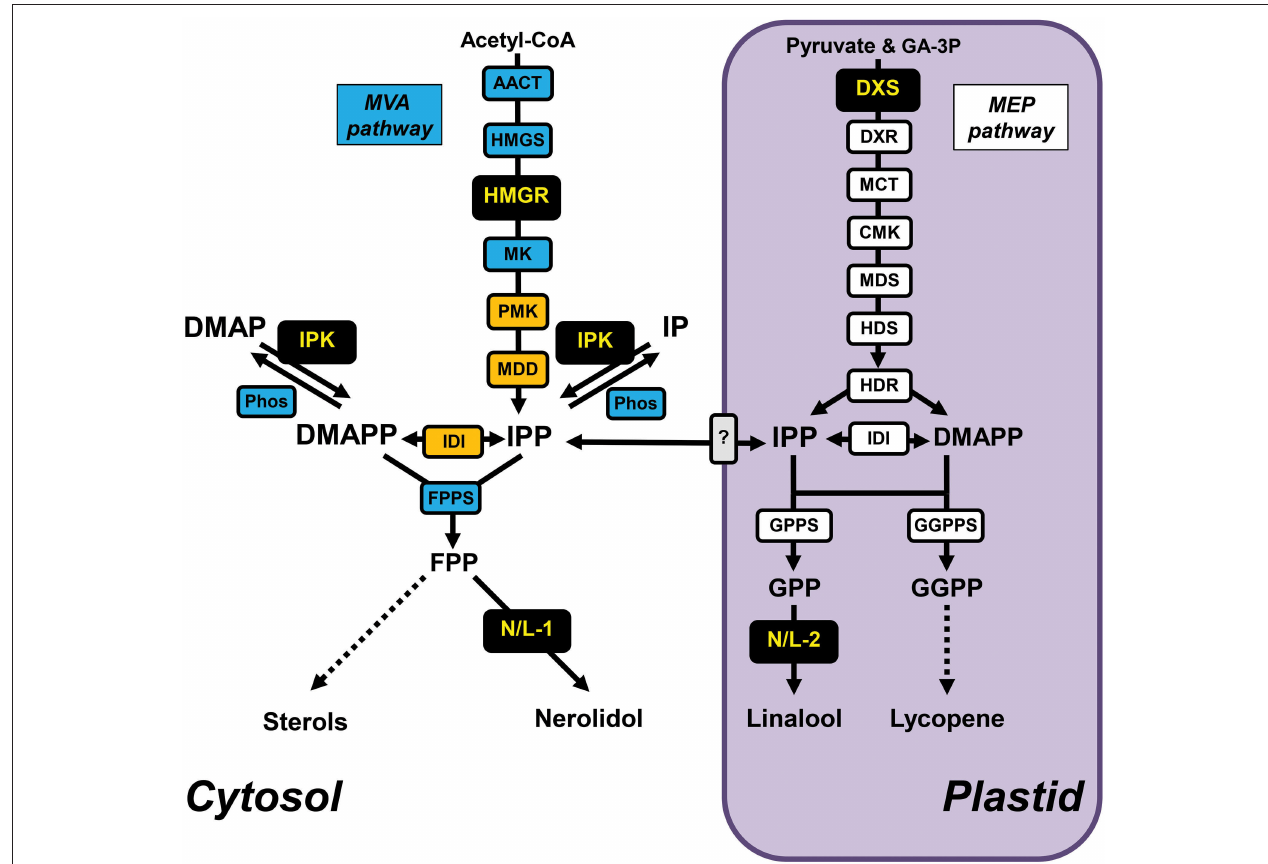
FIGURE 1 | Terpenoid metabolic network in tomato fruits and position of engineered enzymes. Cytosolic and plastidic (highlighted in purple) terpenoid metabolic pathways involved in the biosynthesis of sterols and lycopene in tomato fruits with individual enzymes depicted as boxes. The cytosolic MVA pathway enzymes, prenyl transferase, and Nudix hydrolase are highlighted in blue, peroxisomal MVA pathway enzymes are highlighted in orange, the plastidic MEP pathway enzymes and prenyl transferases are highlighted in white. The unknown transporter(s) involved in IPP exchange across the plastid envelope membranes are shown in gray. The enzymes that have been overexpressed in tomato fruits for metabolic engineering are highlighted in black, including the Antirrhinum majus terpene synthases AmNES/LIS-1 (N/L-1) and AmNES/LIS-2 (N/L-2) catalyzing the formation of nerolidol and linalool, respectively. Dashed lines indicate multiple enzymatic steps. AACT, acetoacetyl-CoA thiolase; CMK, 4-(cytidine 5’-diphospho)-2- C -methyl-D-erythritol kinase; DMAP, dimethylallyl phosphate; DMAPP, dimethylallyl diphosphate; DXR, 1-deoxy-D-xylulose 5-phosphate reductoisomerase; DXS, 1-deoxy-D-xylulose 5-phosphate synthase; FPP, farnesyl diphosphate; FPPS, farnesyl diphosphate synthase; GA-3P, D-glyceraldehyde 3-phosphate; GPP, geranyl diphosphate; GPPS, geranyl diphosphate synthase; GGPP, geranylgeranyl diphosphate; GGPPS, geranylgeranyl diphosphate synthase; HDR, ( E )-4-hydroxy-3-methylbut-2-enyl diphosphate reductase; HDS, ( E )-4-hydroxy-3-methylbut-2-enyl diphosphate synthase; HMGR, 3-hydroxy-3-methylglutaryl-CoA reductase; HMGS, 3-hydroxy-3-methylglutaryl-CoA synthase; IDI, isopentenyl diphosphate isomerase; IPK, isopentenyl phosphate kinase; IP, isopentenyl phosphate; IPP, isopentenyl diphosphate; MCT, 2- C -methyl-D-erythritol 4-phosphate cytidylyltransferase; MDD, mevalonate diphosphate decarboxylase; MDS, 2- C -methyl-D-erythritol 2,4-cyclodiphosphate synthase; MK, mevalonate kinase; Phos, Nudix hydrolase(s); PMK, phosphomevalonate